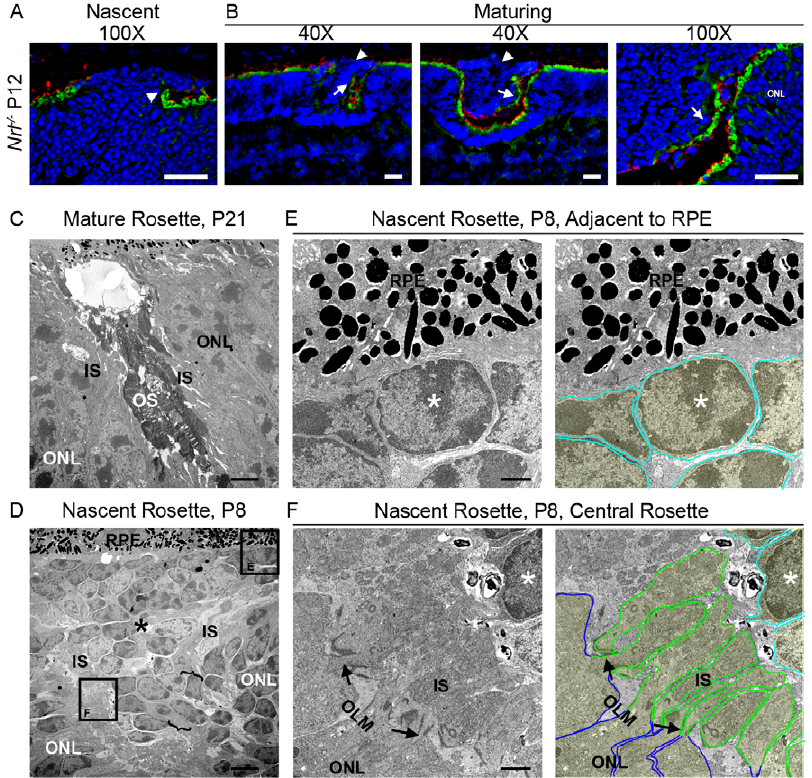
Figure 5. The aberrant photoreceptors in nascent rosettes do not exhibit IS/OSs. A–B . Transitional rosettes captured at P12 were labeled with PNA (green) and S-opsin (red). IS/OS labeling ends abruptly at the base of the aberrant photoreceptors in nascent rosettes ( A -arrowhead), but can be seen along the edge of the populating of aberrant photoreceptors of maturing rosettes ( B -arrow). Ultrastructural comparison of a mature ( C ) and nascent ( D ) rosette confirms the morphological characteristics observed using IHC including aberrant photoreceptors ( D–F -asterisk). Black boxed regions in D are shown at higher magnification in E–F . E . Representative section of aberrant photoreceptors abutting the RPE. F . Representative section of aberrant photoreceptors inside the rosette. The ONL cells exhibit clear ISs protruding into the rosettes while the aberrant photoreceptors cells do not. Dark blue: ONL cell bodies; green: ONL IS; light aqua; aberrant photoreceptor cell bodies. Scale bar, A–B, 20 m m, C–D 4 m m E–F 1 m m.